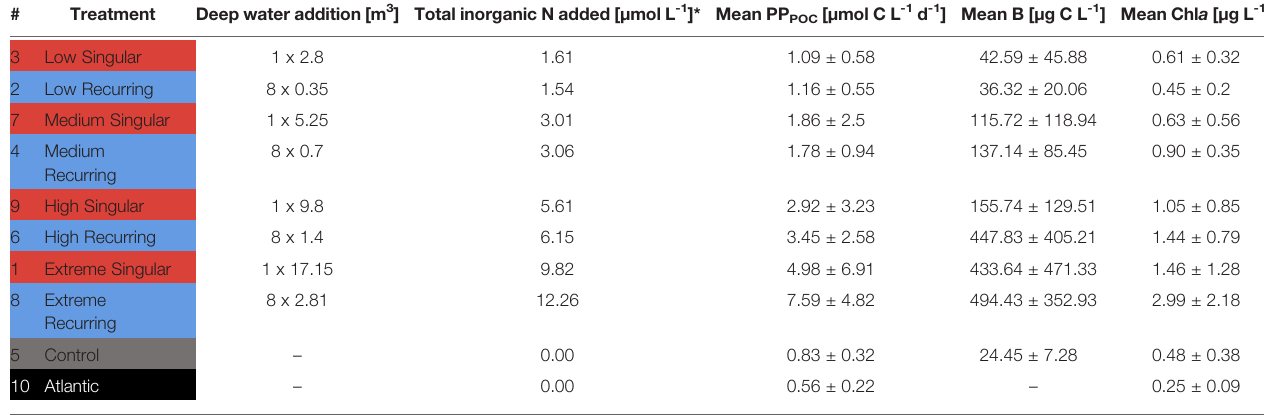
TABLE 1 | Treatment overview, total inorganic nutrients added and mean values for particulate primary production (PP POC ), Biomass (B) and Chlorophyll a (Chla). #